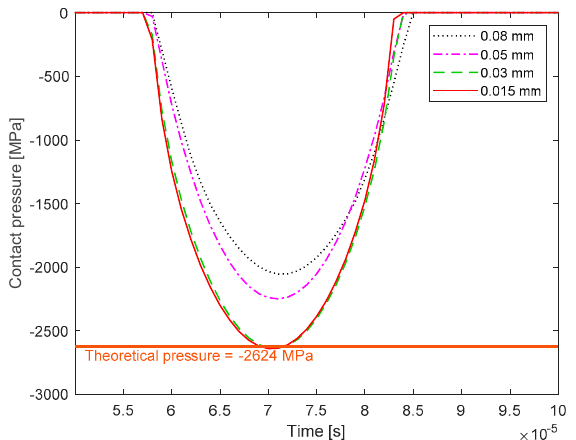
Figure 8. A comparison between the theoretical and numerical impact forces obtained for different mesh size.